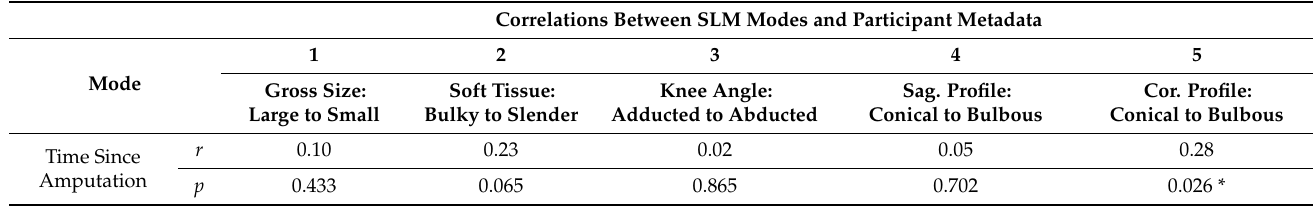
Table A1. Correlations between statistical limb model mode scores and participant